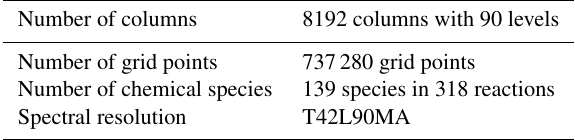
Table 1. Experimental set-up for JUDGE scalability test out-of-the- box.